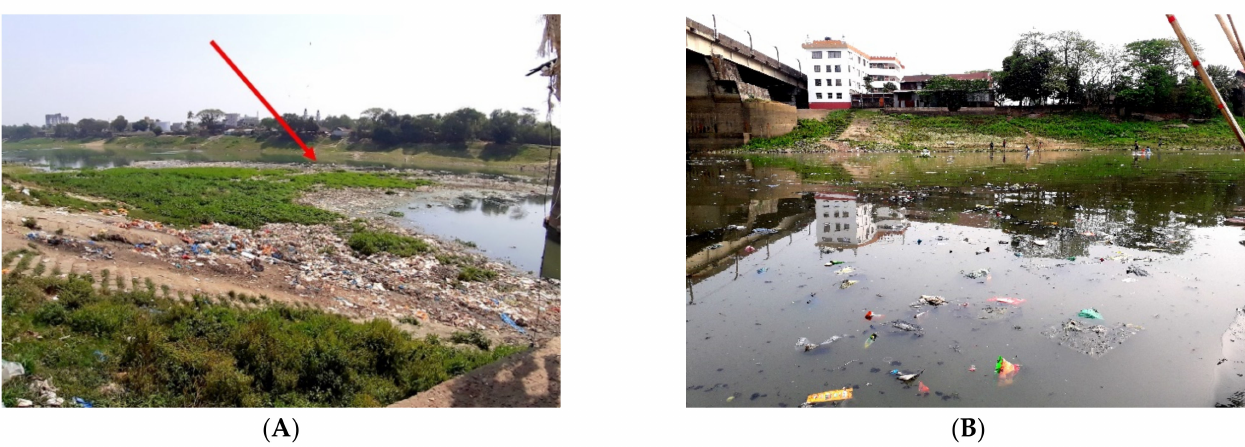
Figure 9. Pollution scenario in the Surma River at Kazir Bazar (S4) study area (captured in March 2022). ( A ) Photo indicates high plastic deposition in the riverbed, while ( B ) shows the plastic frequency in the river